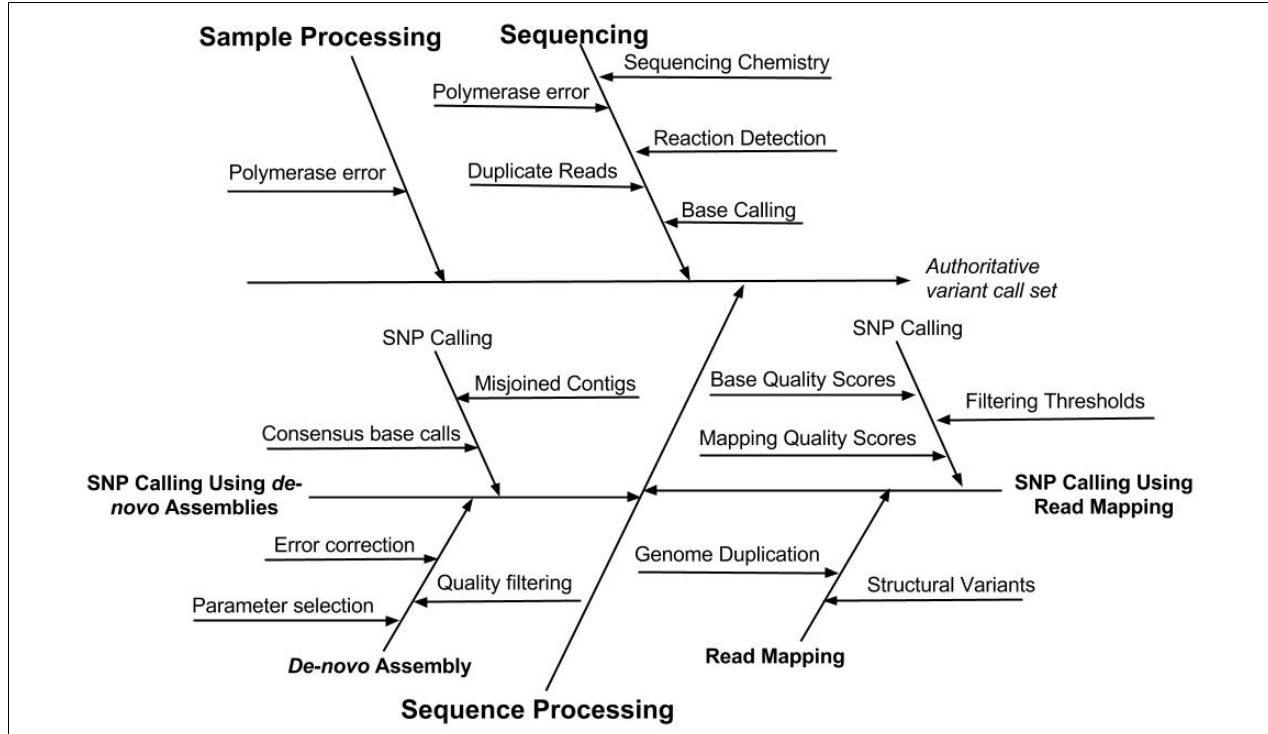
FIGURE 2 | Cause-effect diagram indicating the sources of error associated with different steps in the variant calling measurement process. Note that the SNP calling is performed using one of two methods, either read mapping or de novo